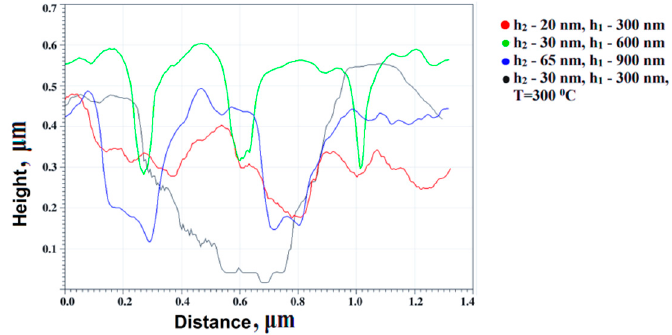
Figure 3. AFM profilograms: h 1 —300 nm, h 2 —20 nm (red); h 1 —600 nm, h 2 —30 nm (green); h 1 —900 nm, h 2 —65 nm (blue); h 1 —300 nm, h 2 —30 nm, Т = 300 ° С (black).